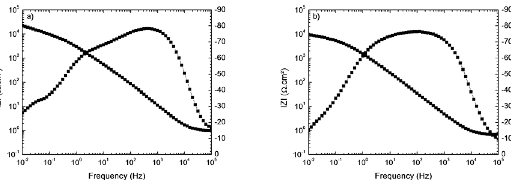
Figure 8. Bode diagrams of uncoated Ti–6Al–4V alloy in 2 M NaOH: a) at 25, b) at 60 °C.